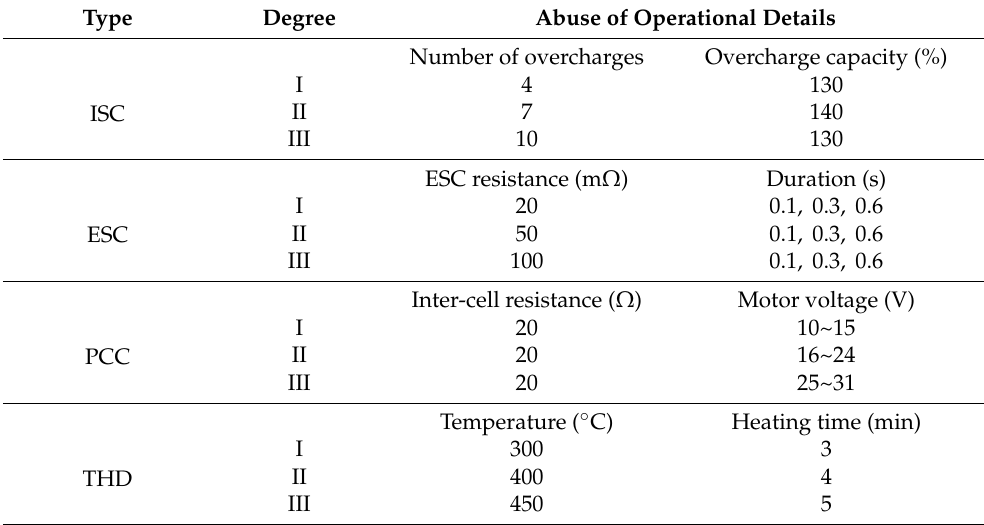
Table 2. Abuse configuration to induce different